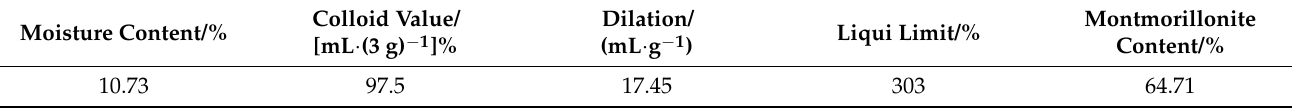
Table 2. Basic physical properties of bentonite.